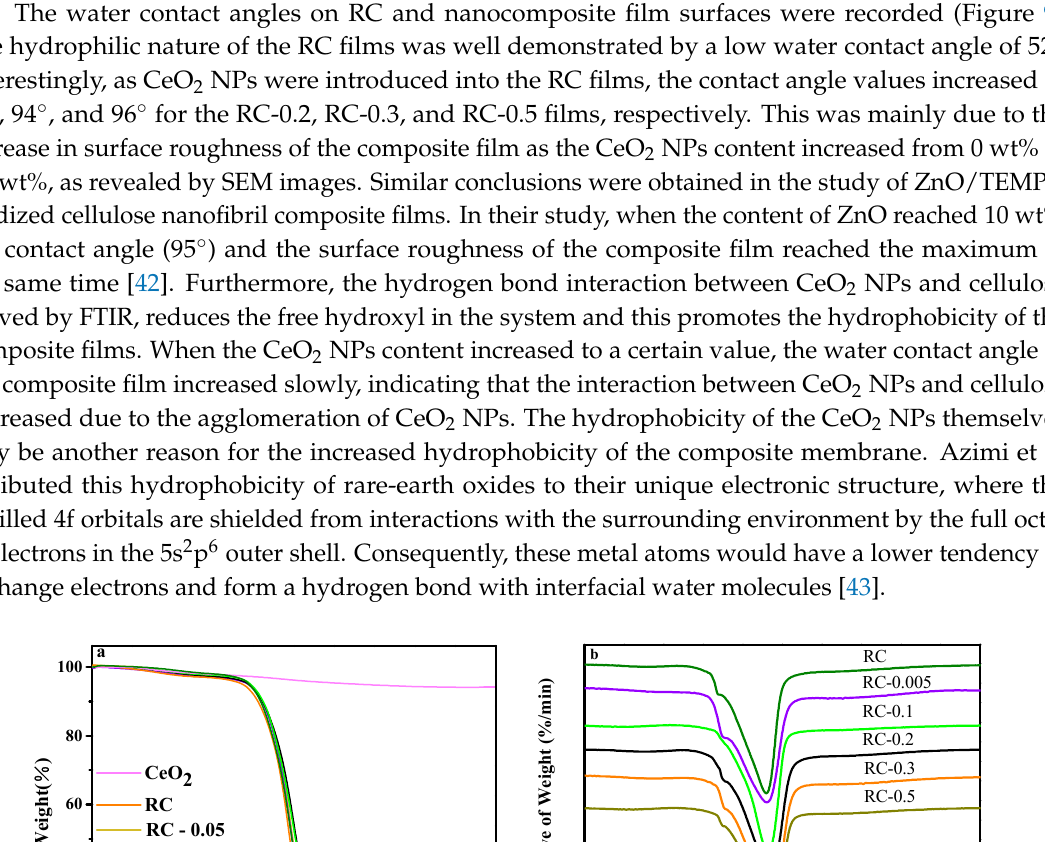
Figure 9. Static contact angle of the RC and RC/CeO 2 nanocomposite films. 4. Conclusions In summary, a direct and facile synthetic strategy was provided to successfully incorporate nanodispersed CeO 2 particles in RC films, thereby affording UV-shielding nanocomposite films. The porous RC film with a lot of hydroxyl groups can interact with electropositive transition-metal cations and act as effective nanoreactors for in situ synthesis of metal nanoparticles and thereby the function of RC film can be realized. With porous RC film as supporting medium, the morphology and particle size of the CeO 2 NPs and accordingly the properties of as-prepared nanocomposite films were affected by the concentrations of the precursor and the porous structure of RC film.